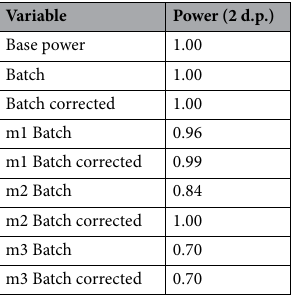
Table 1. Power for genomics simulation. Only ComBat is used for evaluation of power for Genomics Simulation based on statistical feature selection. Higher values indicate better performance (higher recall of correct features).